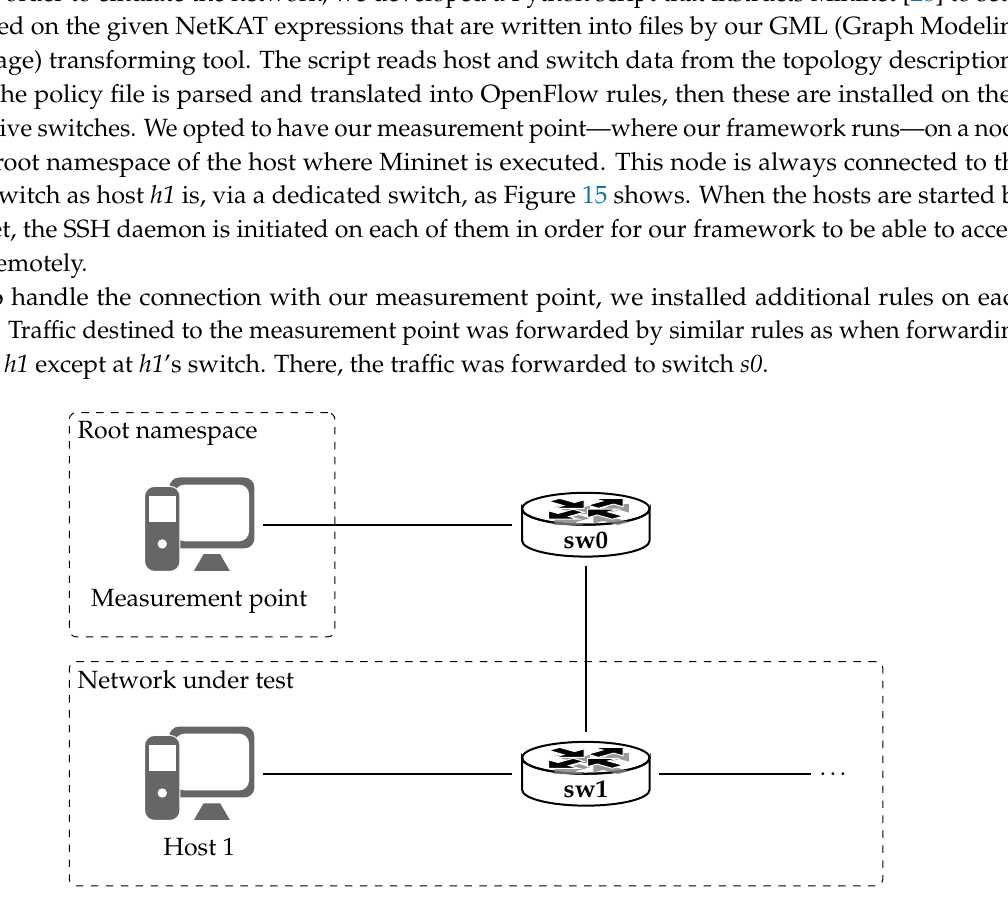
Figure 15. Connection of the measurement point to the network under